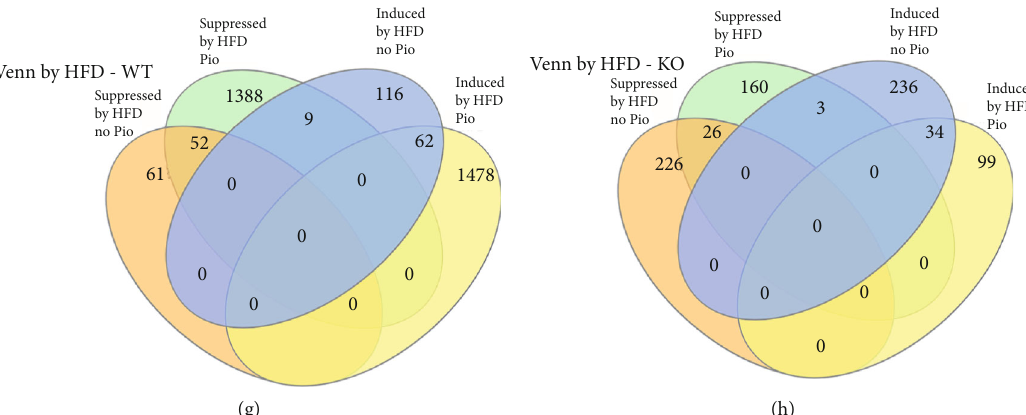
Figure 4: E ff ects of Pio on the hepatic transcriptome. (a, b) Principle component (PCA) and (c, d) heat map analyses of di ff erentially expressed genes from RNA-Seq analyses of livers from (a, c) WT or (b, d) KO mice treated with control diet, Pio, HFD, or HFD and Pio. Heat map analyses are based on Pio-induced di ff erences in gene expression. (e – h) Venn diagrams (generated using InteractiVenn [42]) depict overlap between di ff erentially expressed genes by treatment group in WT (e, g) or KO (f, h)